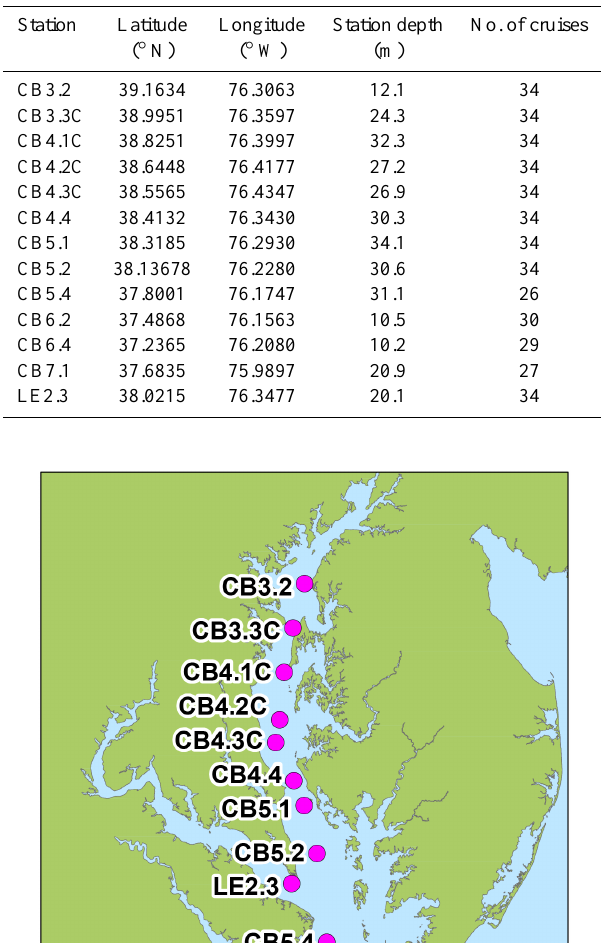
Table 2. Characteristics of observation stations (from USEPA, 2012).